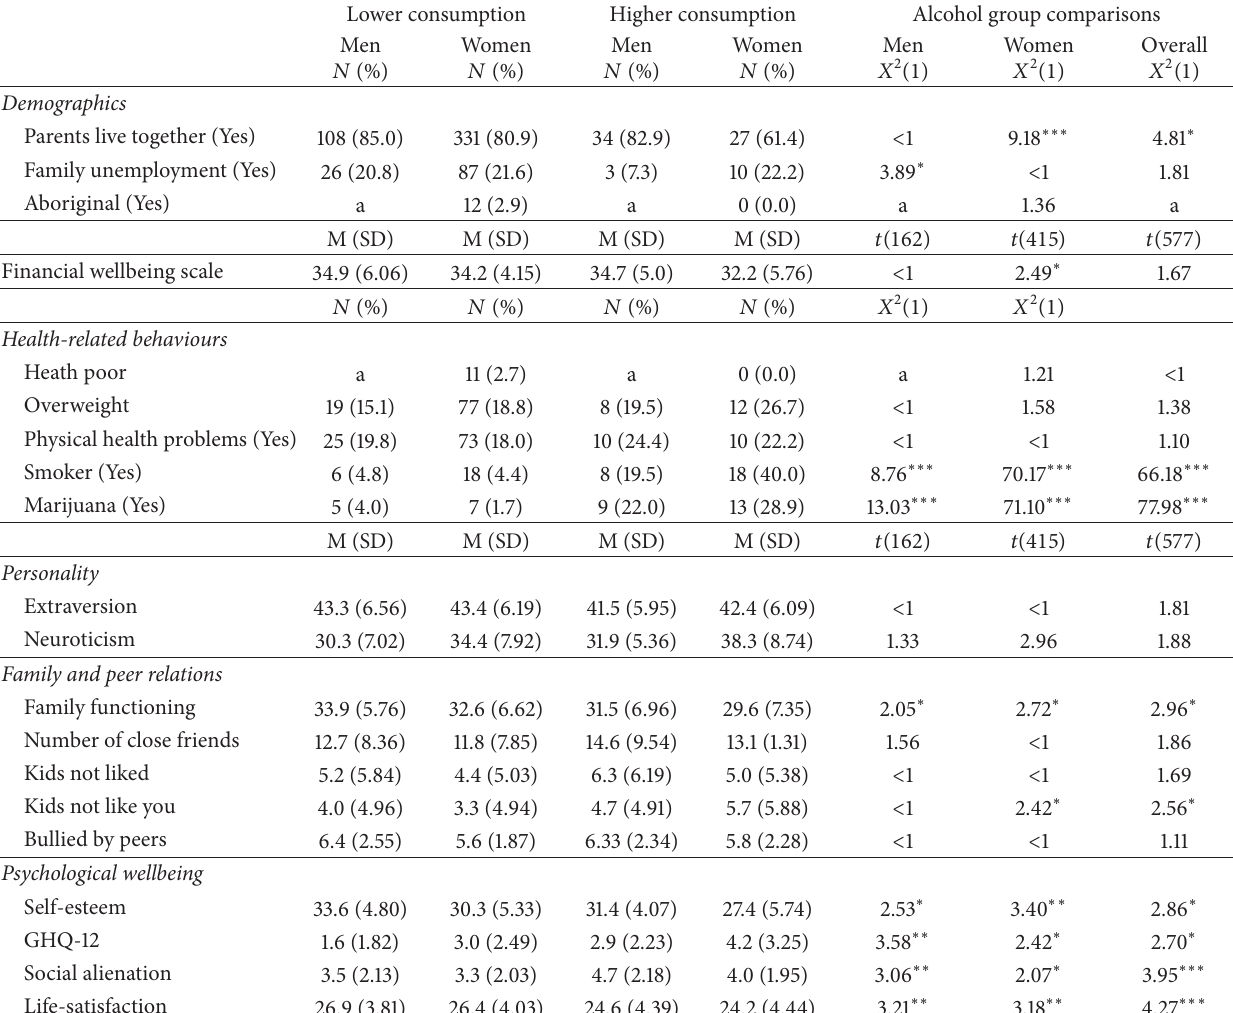
Table 2: Comparative characteristics of alcohol consumption